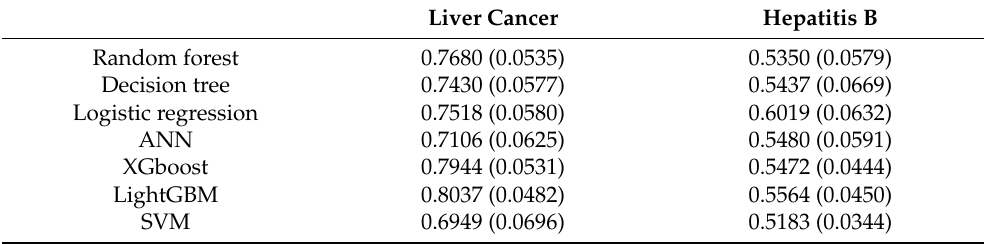
Table 19. AUC values of multi-disease risk association models and comparative